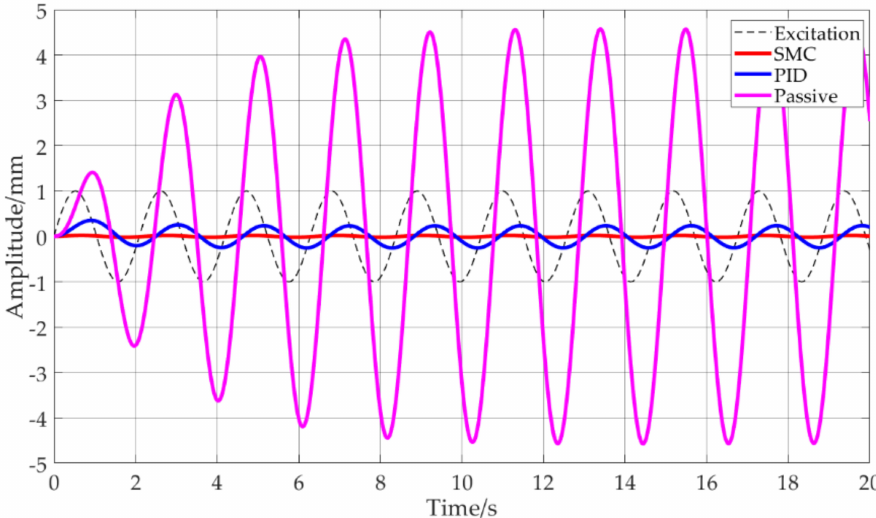
Figure 6. Comparison of the SMC, PID and the passive system under excitation of a sinusoidal signal with an amplitude of 1 mm and a frequency of 3